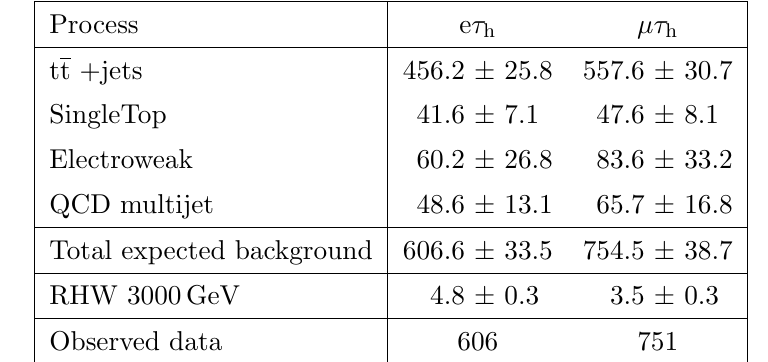
Table 1 . Number of events observed in the e (cid:28) h and (cid:22)(cid:28) h channels of the LQ analysis compared to the background expectations and to the event yield expected for a representative LQ signal of mass 900 GeV. The quoted uncertainties represent the sum of statistical and systematic uncertainties and are obtained by the binned maximum likelihood (cid:12)t of the distribution in S T , as described in the text.